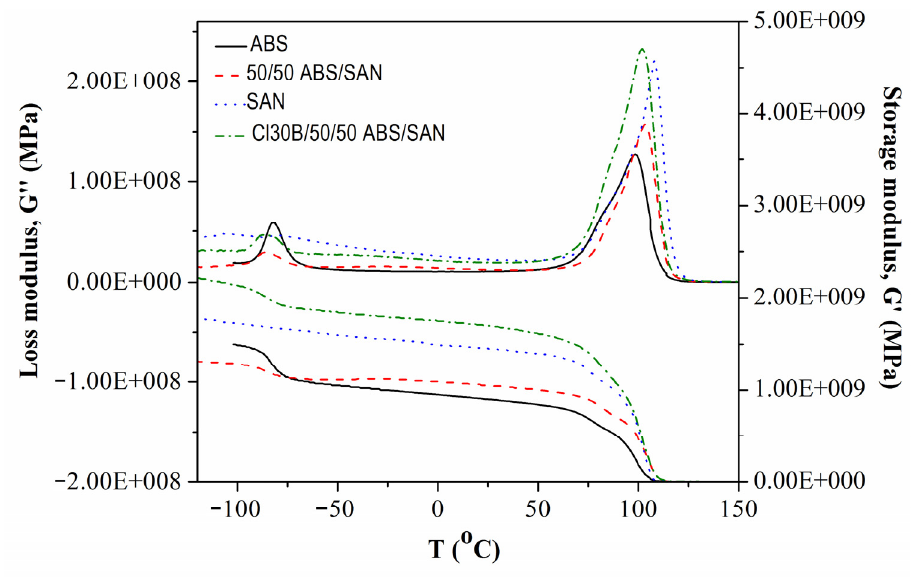
Figure 6. Storage modulus (G ʹ ) and loss modulus (G ʹʹ ) of ABS, SAN, 50/50 w / w ABS/SAN blend and its nanocomposite.